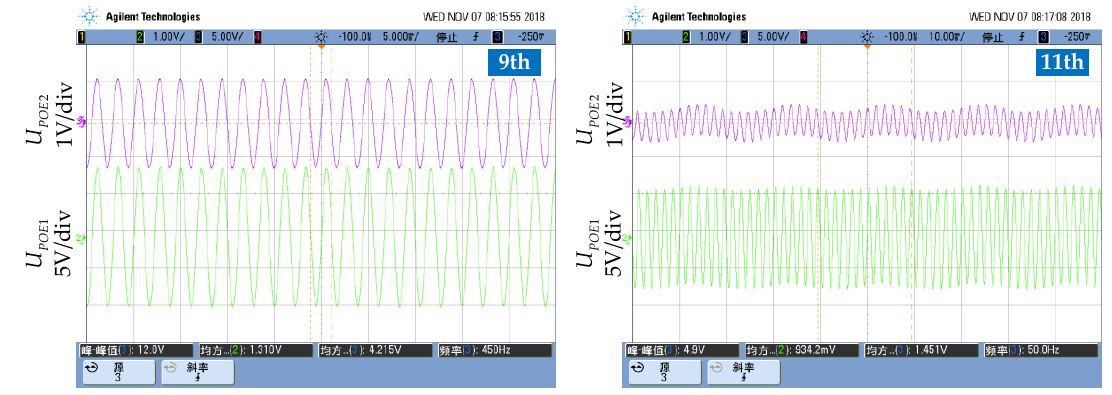
Figure 15. Experimental results of harmonic voltage at the point of evaluation 1 (POE1) and POE2 (9 th , 11 th harmonic).